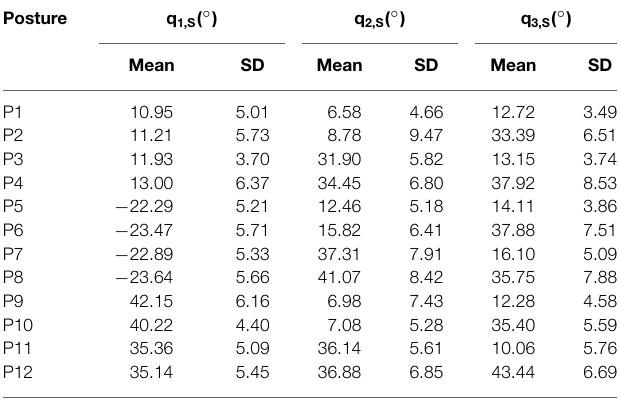
TABLE 3 | Actual starting joint angle